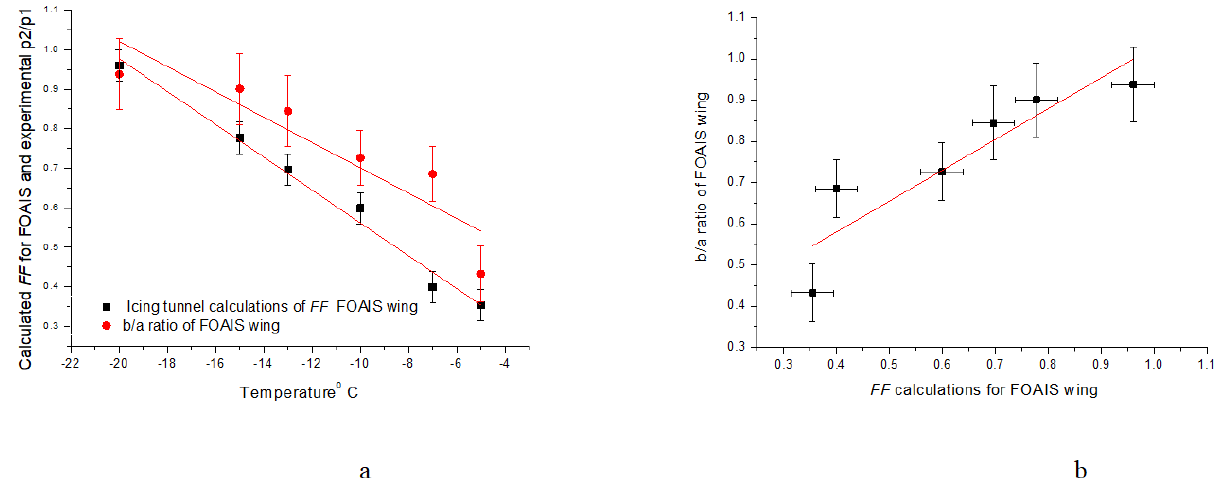
Figure 15. Comparison of b/a parameter with FF : ( a ) Scattering and reflection intensities ratio b/a parameter as a function of temperature, (red trace), and calculated FF of the wing in the icing tunnel (repeated trace taken from Figure 13). ( b ) Correlation of FF of our wing in icing tunnel, with the b/a parameter.